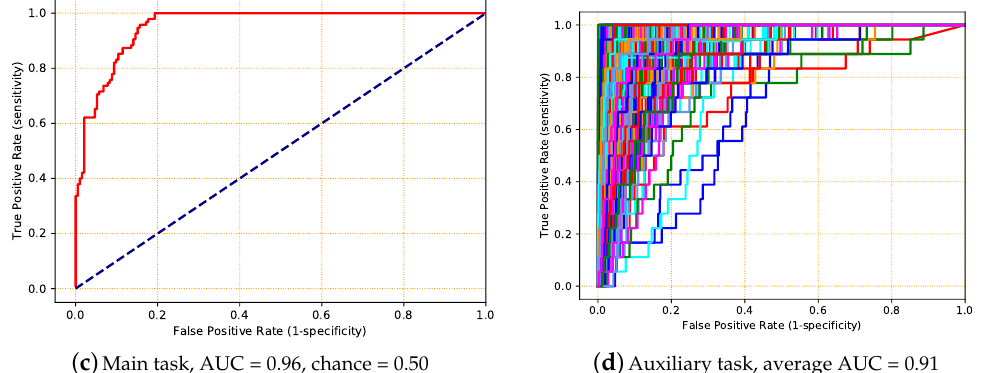
( c ) Main task, AUC = 0.96, chance = 0.50 Figure 8. A sample of obtained ROCs for multi-task deep learning (MTDL) with fall status as the main task and subject identity as the auxiliary task. For the auxiliary task, the ROCs were computed using one-versus-all. The corresponding average AUC is reported. For ( a , b ), the main and auxiliary losses were given the same weight (1:1); for ( c , d ), the main loss function was given higher weight (10 4 :1) than the auxiliary loss function. The dashed blue lines in ( a , c ) represent the chance ROC.